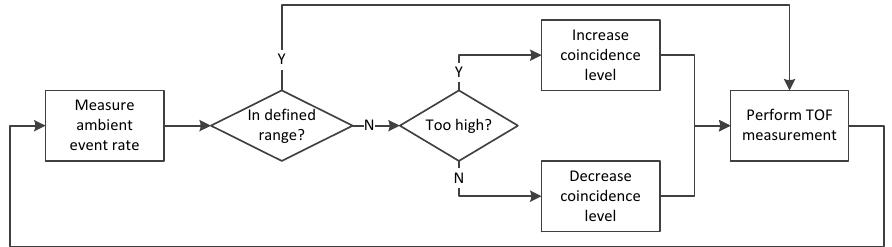
Figure 8. Flow chart of a possible coincidence adjustment algorithm. After the ambient event rate is measured, the coincidence level is increased or decreased if it is outside the defined rate range.